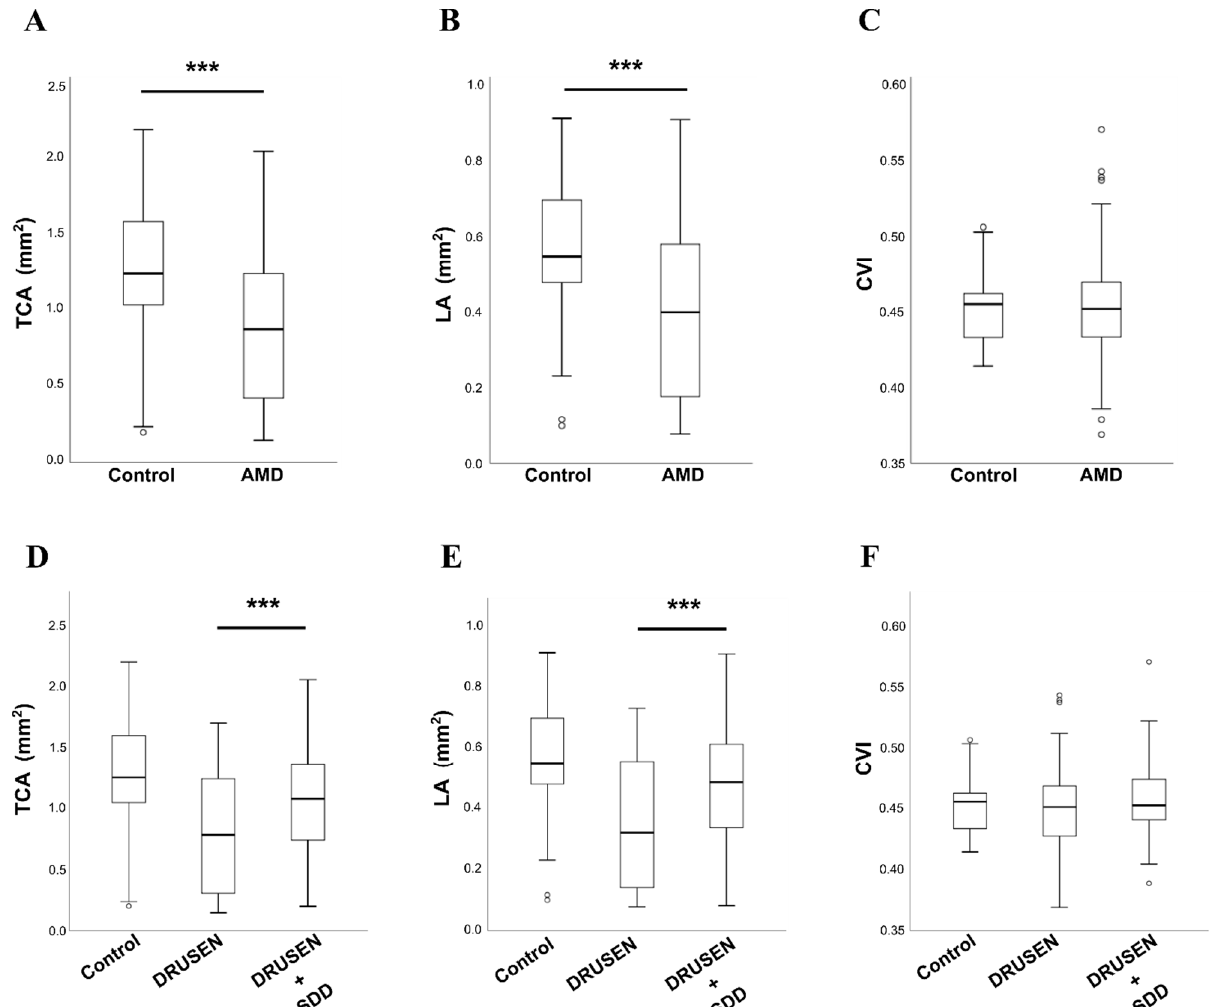
Figure 3. Choroid evaluation in intermediate AMD. ( A – C ) Graphical distribution of total choroidal area (TCA), luminal area (LA) and choroidal vascularity index (CVI), respectively, among control and AMD groups through box plots. ( D – F ) Box plots displayed the distribution of TCA, LA and CVI, respectively, among the control group and the two sub-groups (i.e., DRUSEN and DRUSEN + SDD) defined among AMD patients. Box-and whisker plots show median, first and third quartile, the whiskers extend to 1.5 times the interquartile range (IQR) (values exceeding this are plotted as individual points). TCA: Total choroidal area; LA: Luminal area; CVI: Choroidal vascularity index; DRUSEN: soft or cuticular drusen; DRUSEN + SDD: drusen in association with subretinal drusenoid deposits. (*** p -value ≤ 0.001).